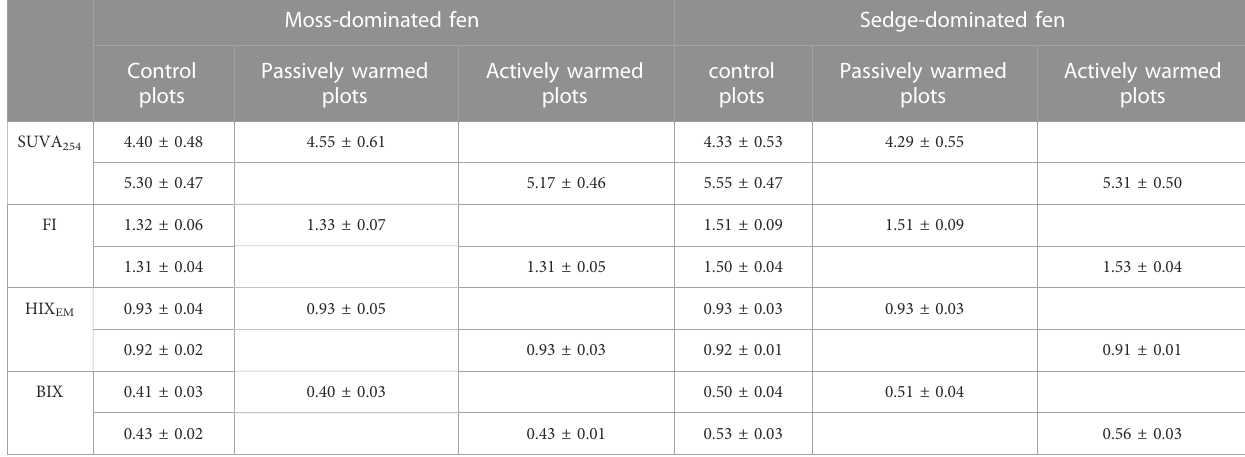
TABLE 2 Measures of speci fi c ultraviolet absorbance at 254 nm (SUVA 254 , L mg C − 1 mL − 1 ) and fl uorescence indices (FI, HIX EM , and BIX) in pore waters under the groundwarmingtreatmentatmoss-andsedge-dominatedsites.PassivewarmingwasfromJunetoOctoberin2017,2018and2019;activewarmingwasfromJuly to September in 2019. Control and Experimental Plot data are paired by year. Values are presented as mean ± standard